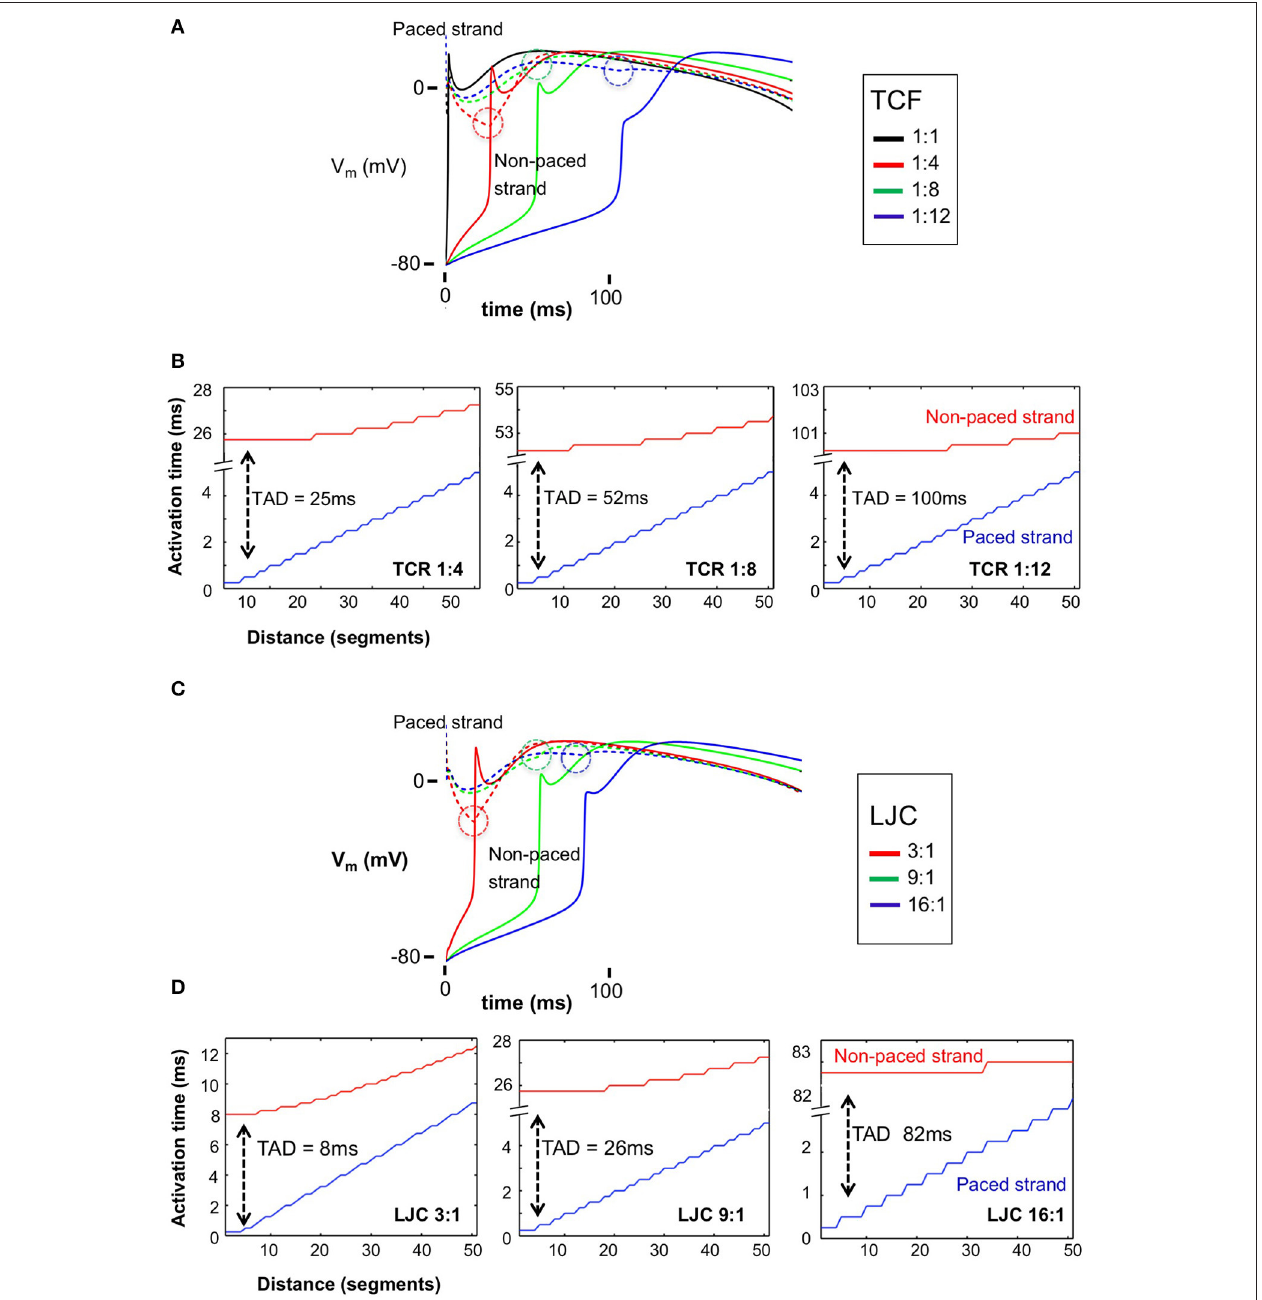
FIGURE 2 | Action potentials (APs) and transverse activation delay (TAD) for the paced and non-paced strands with varied discrete TCF and LJC. (A) APs for the stimulus location in the paced strand (dashed lines) and the directly opposite myocyte in the non-paced strand (solid lines) with TCF = 1:1, 1:4, 1:8, 1:12, respectively. The dashed circles highlight the timing of electrotonic interaction between the paced and non-paced strands; once the non-paced strand was activated, it acted as a current source and that elevated the potential in the paced strand. (B) TADs increased dramatically with decreased TCF from 25ms (TCF = 1:4) to 100ms (TCF = 1:12), while having little impact on conduction velocity in the paced strand. On the other hand, after a long TAD, activation of the non-paced strand is almost instantaneous. (C) APs for the stimulus location in the paced strand (dashed lines) and the directly opposite myocyte in the non-paced strand (solid lines) with LJC = 3, 9 and 16:1, respectively. The dashed circles highlight the timing of electrotonic interaction between the paced and non-paced strands. (D) TADs increased dramatically with increased LJC from 8ms (LJC = 3) to 82ms (LJC = 16), while having little impact on conduction velocity in the paced strand. With a higher LJC, and a longer TAD, the degree of synchronicity of activation within the non-paced strand increased.